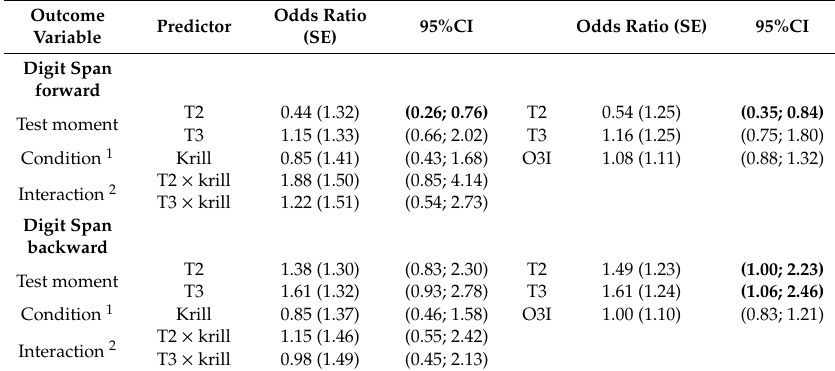
Table 5. Multilevel analyses of Digit Span forward and Digit Span backward, predicted by either condition (intention-to-treat) or Omega-3